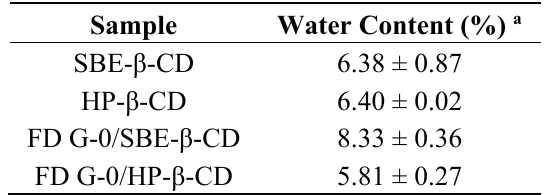
Table 4. Karl Fischer titration (KFT) for the water content of freeze-dried (FD) complexes and cyclodextrins. SBE- β -CD, sulfobutyl ether- β -cyclodextrin; HP- β -CD, 2-hydroxypropyl- β -cyclodextrin.